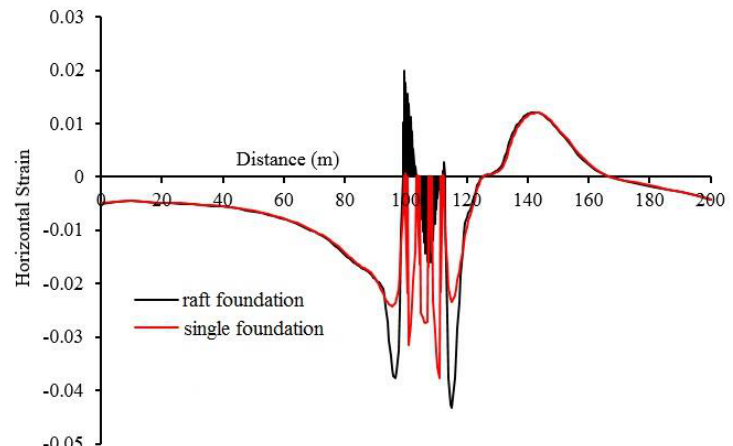
Fig. 21. Comparison of horizontal strain of ground for 5 floor building with single and raft foundation in DS-LS